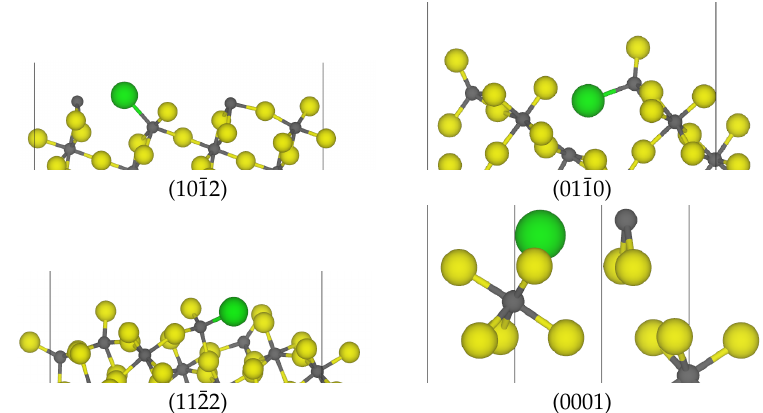
Figure 8. Optimized structures of the bridging chloride substitution of various ACF surface cuts (grey = aluminum, yellow = fluorine, green =